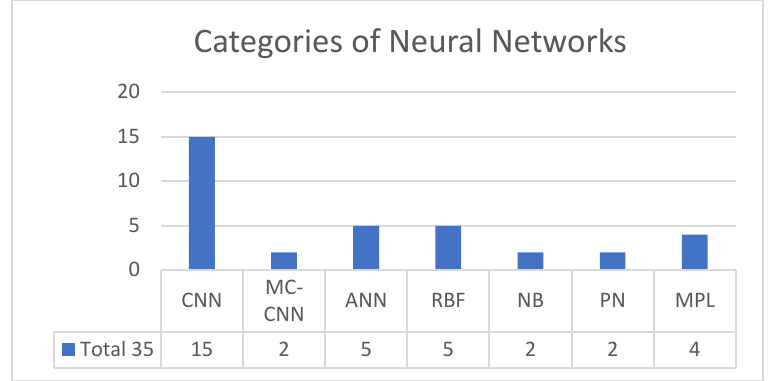
Figure 1. Categories of neural network for automated thyroid nodule detection. The selection of classifiers mainly depends on how well the model is trained and tested. Figure 2 describes the frequency of the different classifiers used in the literature.